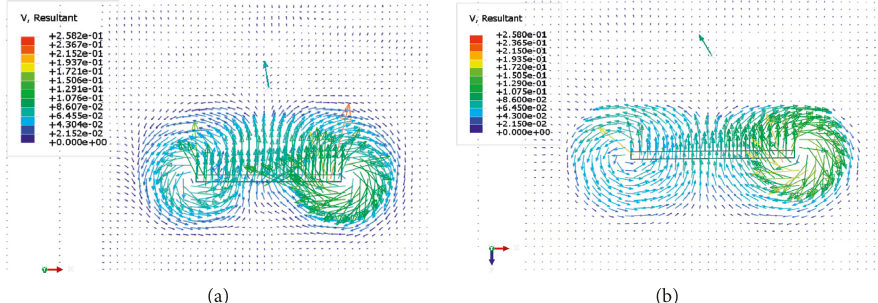
� 28m) when the keying i